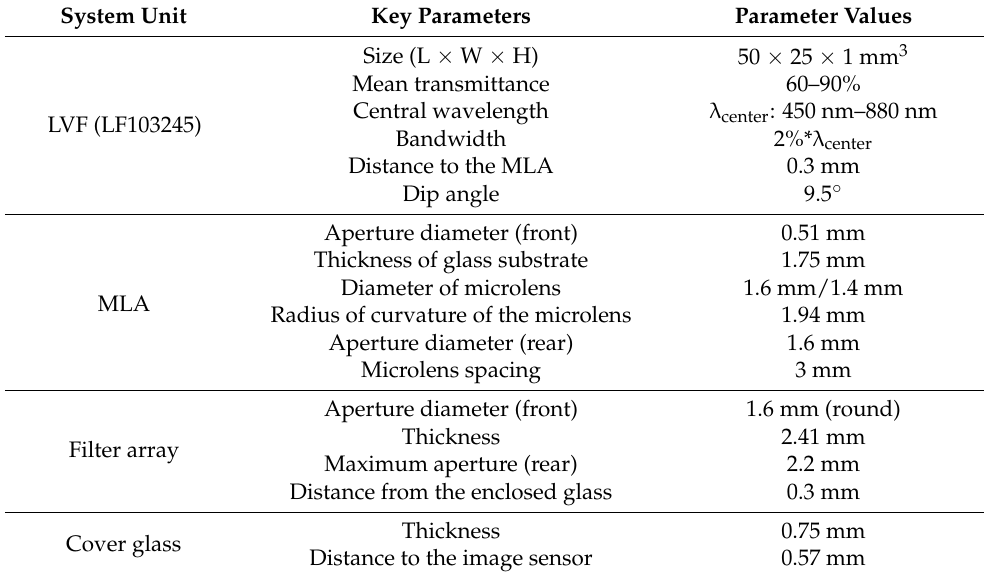
Table 6. Overview of the design parameters of the ultra-compact micro-optical system for MSI.